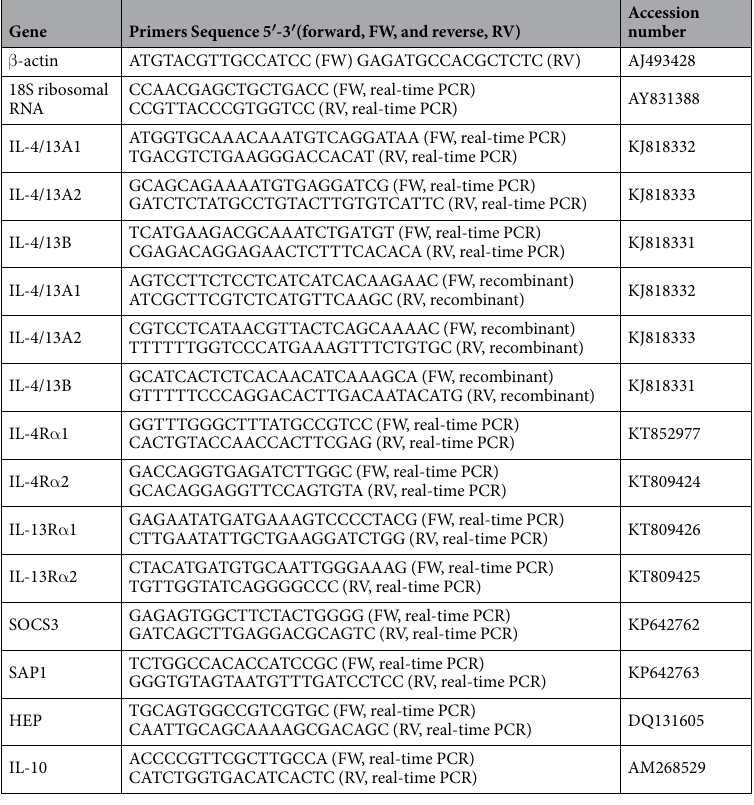
Table 2. Primers used for expression analysis and production of recombinant